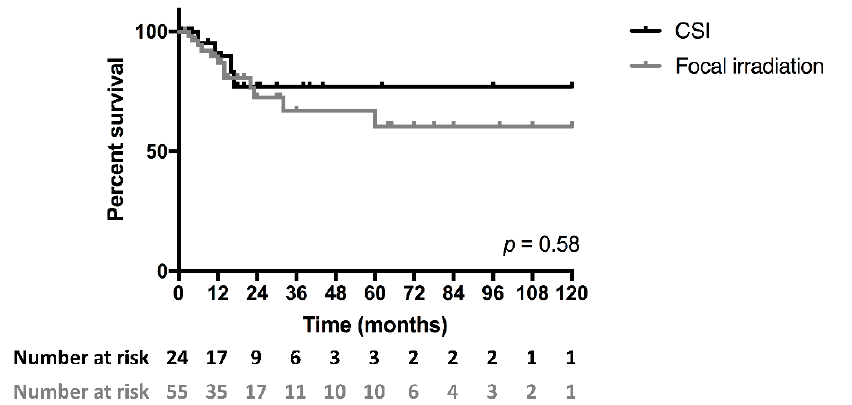
Figure 3. Kaplan–Meier survival curves of patients with intraspinal EwS treated either with CSI or focal RT. No significant difference between cohorts was observed ( p = 0.58).